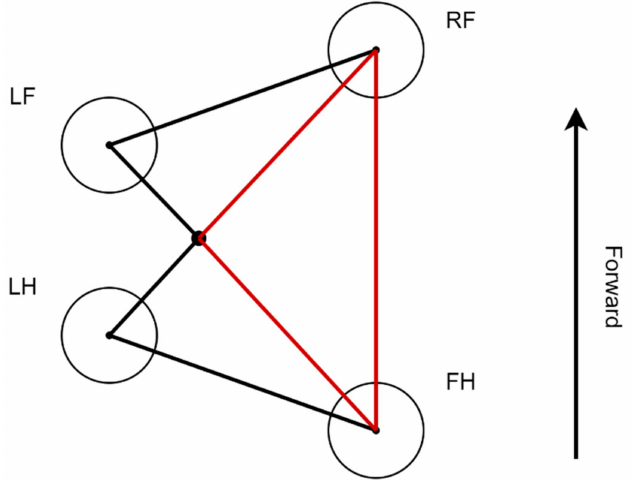
Figure 7. Support